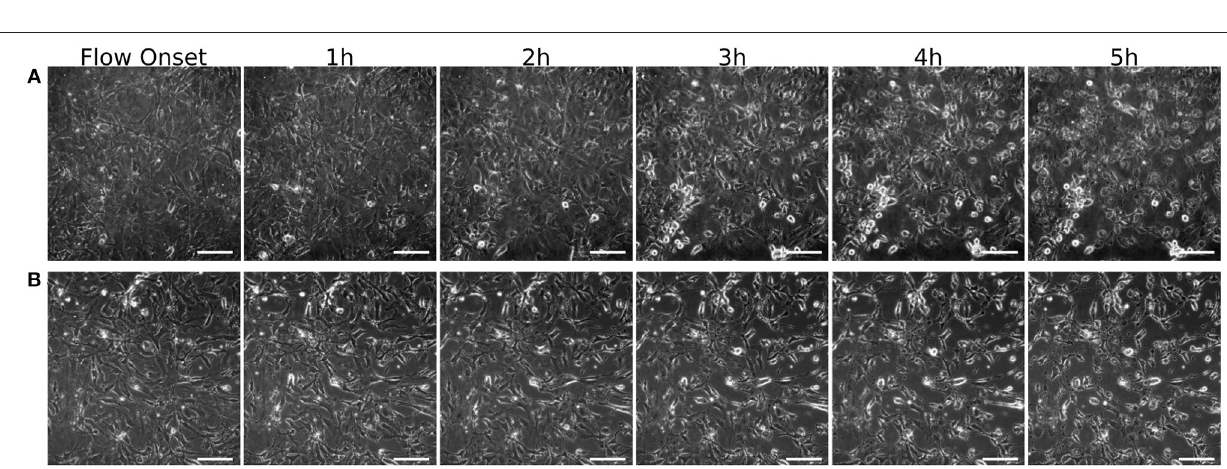
the surface of the glass slide at steady inlet flowrates of 5 ml/min and 20 ml/min, respectively. This, as well as streamlines through the flow chamber, are illustrated in Figure 10